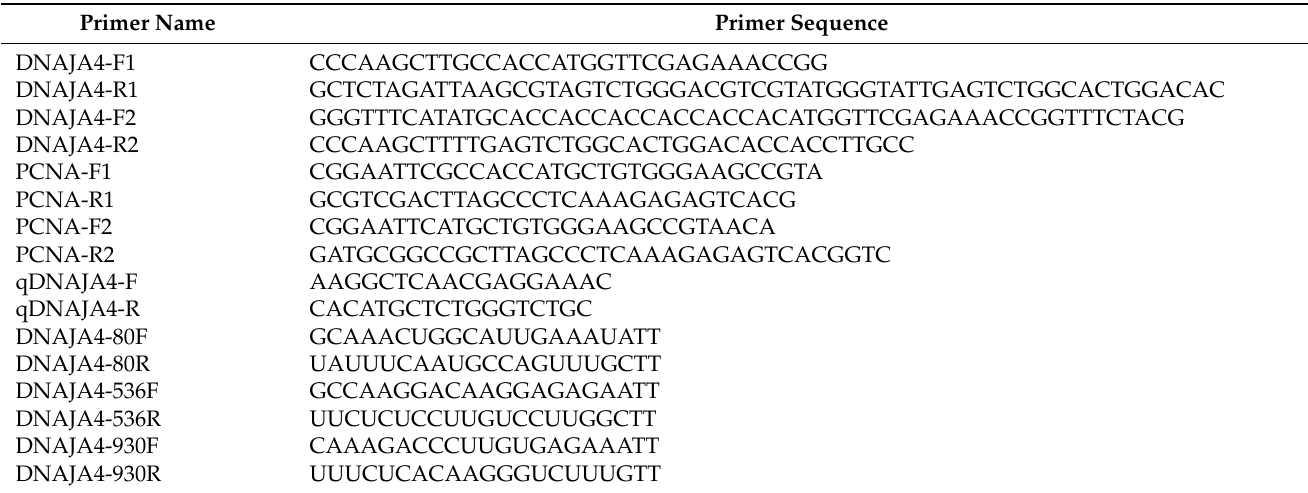
Table 1. Sequence of primers used in this